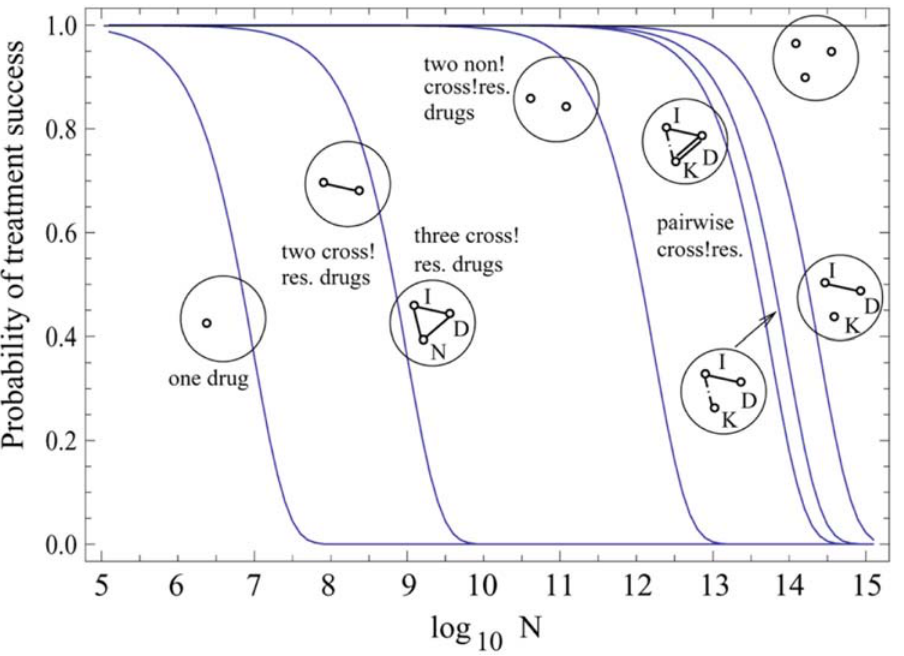
Figure 1. The probability of treatment success is plotted as a function of the colony size, N . Different curves correspond to different combination treatments, with one, two and three drugs. The cross-resistance networks are presented by using connected and disconnected nodes. The number of nodes corresponds to the number of drugs used. Connected nodes correspond to the existence of a cross-resistant mutation. Identical connecting lines indicate that the same mutation confers cross-resistance to all connected drugs. Different (single, double, dashed) lines correspond to different mutations. Simulation parameters are as follows: m =10 2 9 , k=100 , M 0 =100 , d/l=0.5 , h/l=3 . The symbols ‘‘I’’, ‘‘D’’, ‘‘N’’, and ‘‘K’’ stand for ‘‘Imatinib’’, ‘‘Dasatinib’’, ‘‘Nilotinib’’ and a future drug which can bind to T315 mutants.